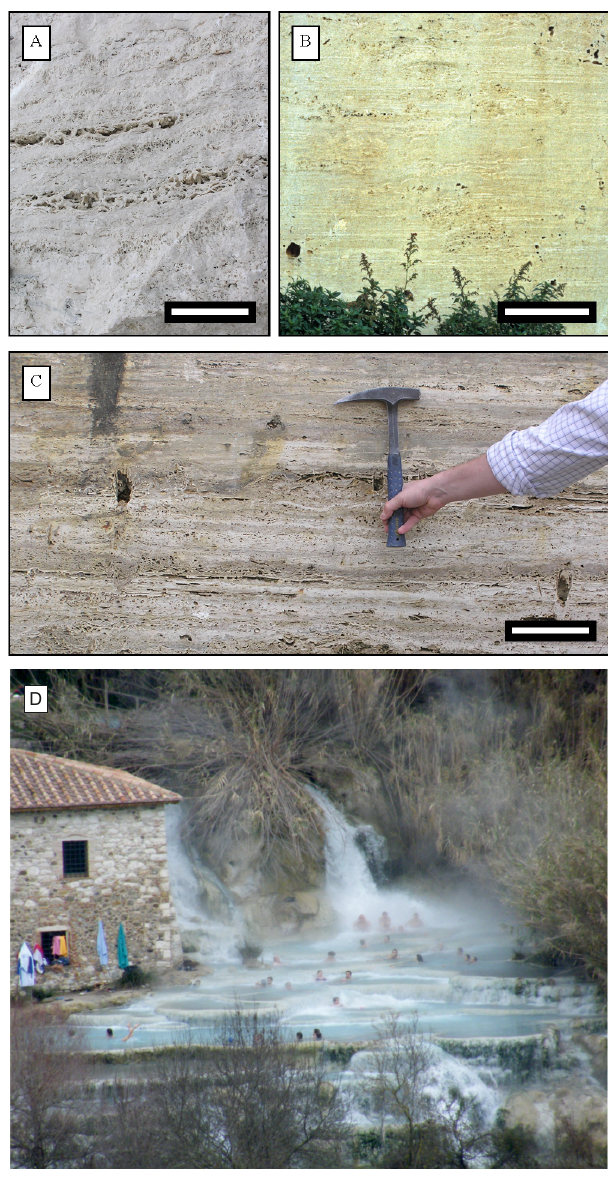
Figure 5. High temperature, low ∆ G r . (A) Laminated travertine with alternating bubble and laminate layering. Scale bar is 50mm long. Holocene, Cava Oliviera, Tuscany, Italy. (B) Laminite-filled pools bounded by bacterial microherm dominated pool rims. Scale bar is 150mm long. Early Quaternary Alcamo travertine, Sicily, Italy. (C) Typical laminated microbial travertine fabric. Scale bar is 150mm long. Holocene Cava Oliviera, Tuscany, Italy. (D) Typi- cal rim pool system from Saturnia, Tuscany, Italy. Note swimmers for scale, and steam rising from warm water (with thanks to Enrico